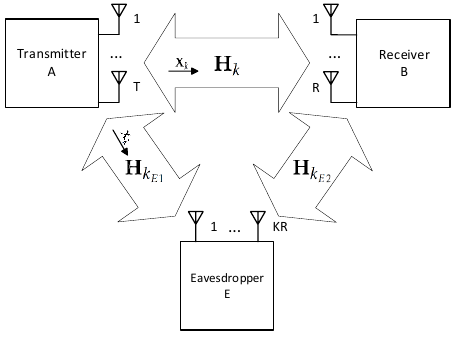
Figure 1. Considered MIMO-SVD system with an eavesdropper.